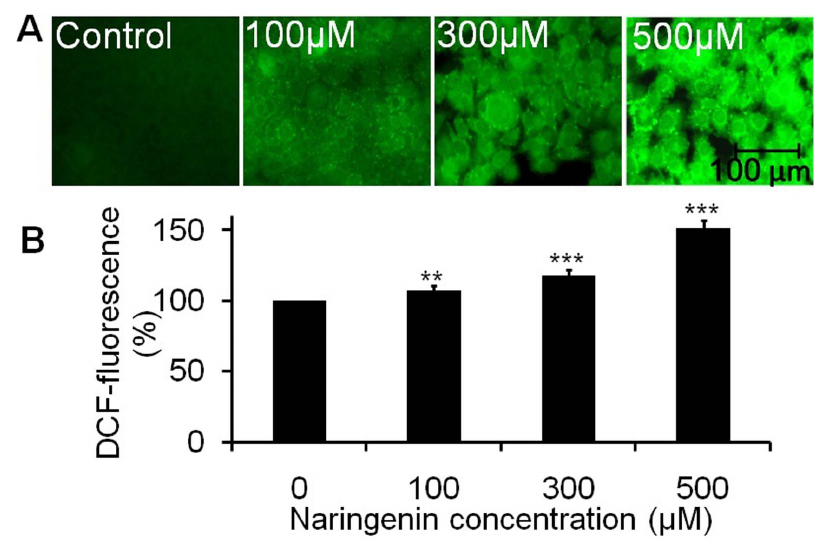
Figure 3. Photomicrographs showing intracellular ROS generation in A431 cells induced by naringenin and stained with DCFH-DA. (A) Photomicrographs showing intracellular ROS generation induced by 100 m M, 300 m M and 500 m M of naringenin after 12 h incubation. Photomicrographs were taken by florescence phase contrast microscope (B) Values are expressed as the percentage of fluorescence intensity relative to the control. Values are expressed as means 6 SD of at least three independent experiments, **p , 0.01 and **p , 0.001 as compared with their respective control.